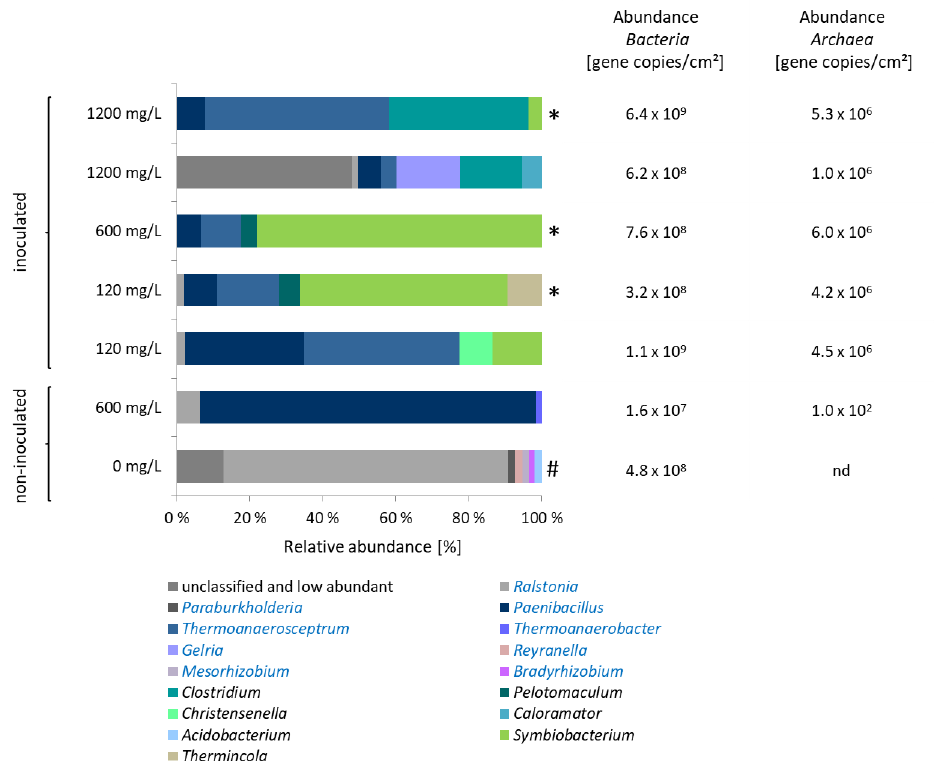
Figure 3. Left: Characterization of the microbial community on coupons in experiments on inhibitor degradation after 355d of incubation. Blue bars: fermentative bacteria. Samples marked with asterisk (*) were inoculated with the 120mg/L inhibitor preculture. Others were inoculated with 1200mg/L preculture. Sample marked with (#) contains no rock. Sequences classified to the genera written in blue letters had an identity to the best database hits of 98%–100%. Genera written in black letters had a sequence identity to the best database hits of 85%–96%. Right: Copy numbers of the 16S rRNA gene of Bacteria and the 16S rRNA gene of methanogenic archaea. nd = not detectable. Table 2. Characterization of the geothermal Fluid at the plant in Unterhaching from 2017 to